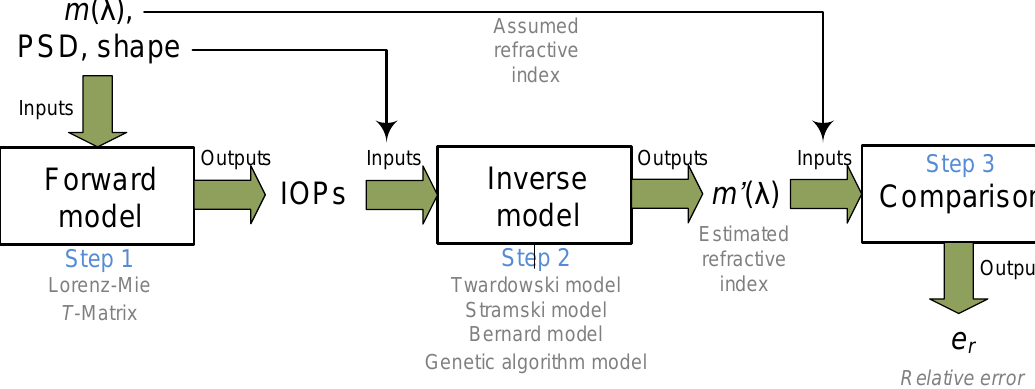
Figure 2. Procedure used to analyze the accuracy of the inverse